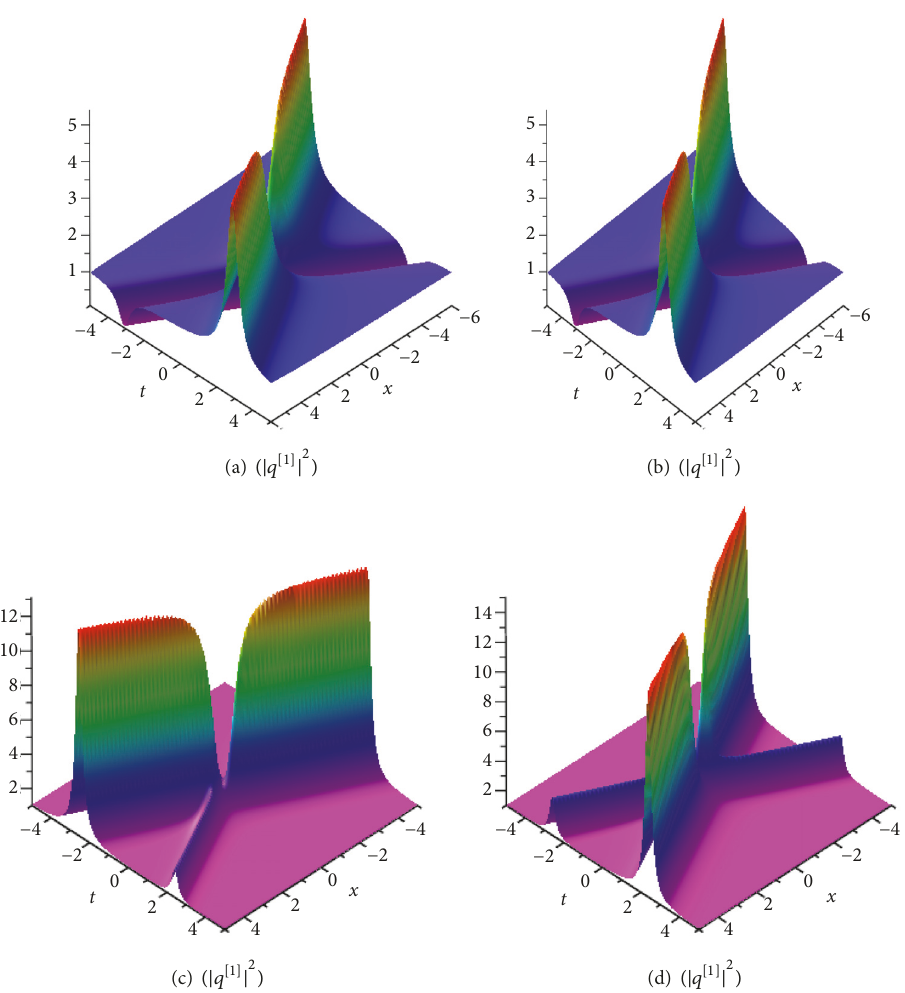
Figure 1: |𝑞 [1] | 2 displays four structures with the height of background being 1. (a) The dark-bright structure: (𝐽 1 ,𝐽 2 ) = (2,3) . (b) The bright- dark structure: (𝐽 1 ,𝐽 2 ) = (0.2,0.2) . (c) The bright-bright 1 structure: (𝐽 1 ,𝐽 2 ) = (0.2,−0.1) . (d) The bright-bright 2 structure: (𝐽 1 , 𝐽 2 ) = (3,−1)